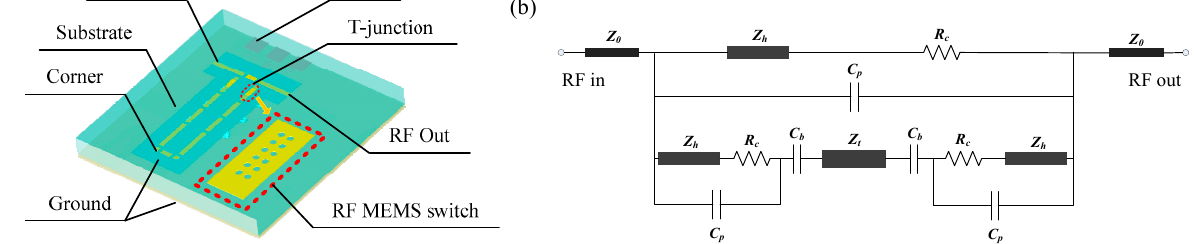
Figure 3. ( a ) Structure of the TTDL unit. ( b ) The “ON” state equivalent circuit diagram of the TTDL unit.